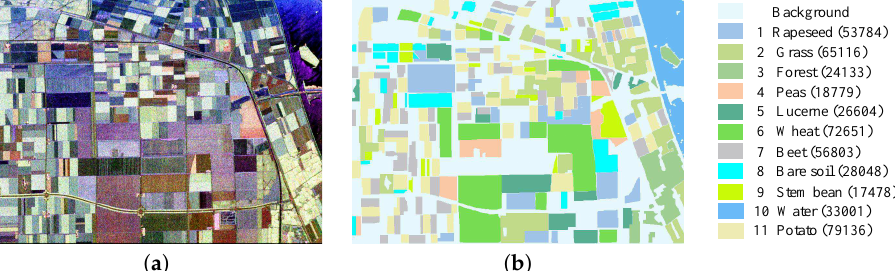
Figure 9. Flevoland dataset. ( a ) Pauli RGB; ( b ) ground truth and corresponding legend (note that the number of each class is given in brackets).